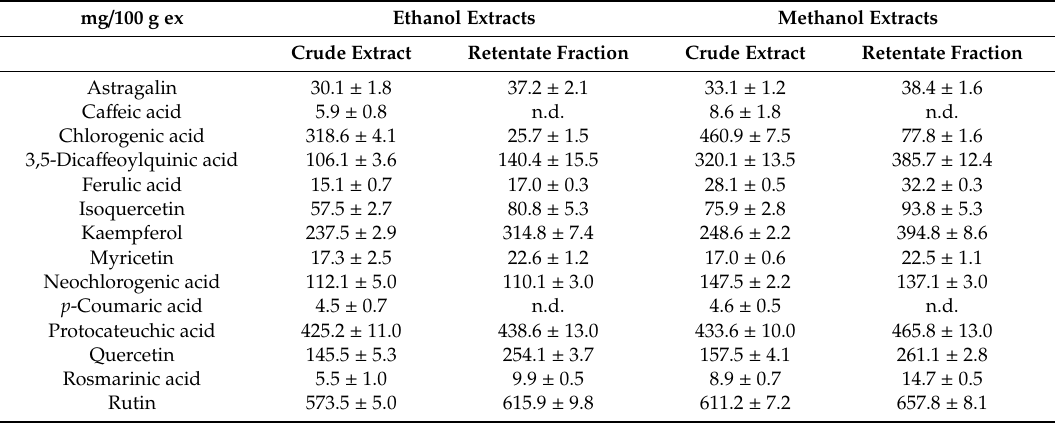
Table 2. HPLC profile of selected phenolic acids and flavonoids of S. nigra floral extracts.